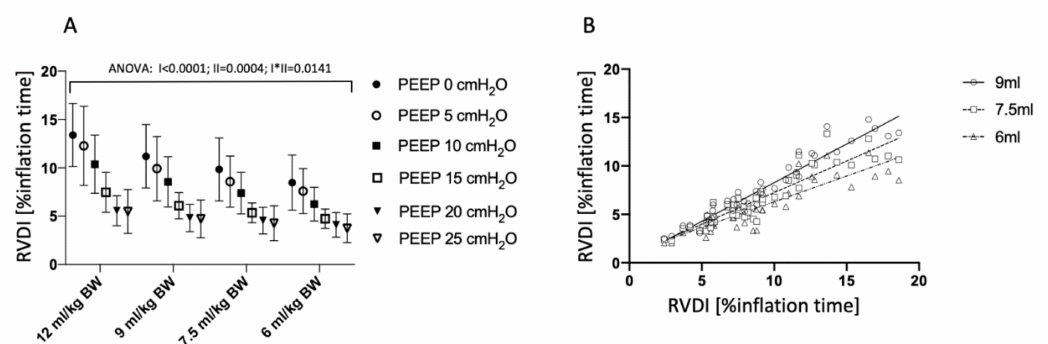
Figure 2. ( A ) Regional ventilation delay inhomogeneity (RVDI) obtained by electrical impedance tomography (EIT) during a slow inflation with tidal volumes of 12, 9, 7.5, and 6 mL / kg at positive end-expiratory pressure (PEEP) levels of 0, 5, 10, 15, 20, and 25 cmH 2 O. Repeated-measures ANOVA: I: factor “PEEP”, II: Factor “slow inflation V T ”; I*II: Interaction of I and II. ( B ) Linear correlation analysis of RVDI (temporal heterogeneity of regional impedance time curves in % inflation time) obtained from electrical impedance tomography (EIT) during a slow inflation of 12 mL / kg BW (x-axis) and RVDI calculated from simulated 9, 7.5, and 6 mL / kg BW inflations performed at PEEP levels of 0, 5, 10, 15, 20, and 25 cmH 2 O.